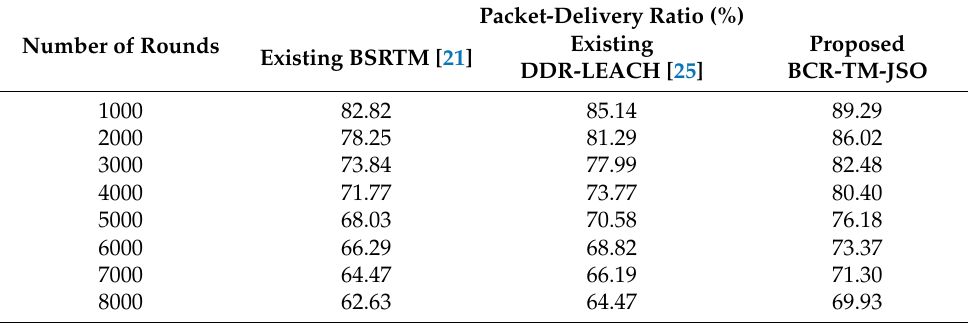
Table 10. Performances of PDR with hierarchical routing